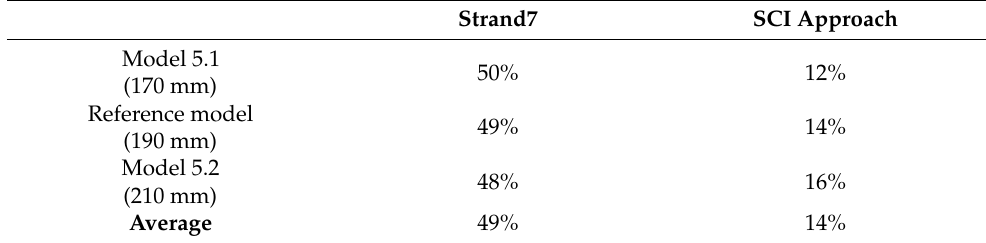
Table 18. Possible error between different approaches (change in slab